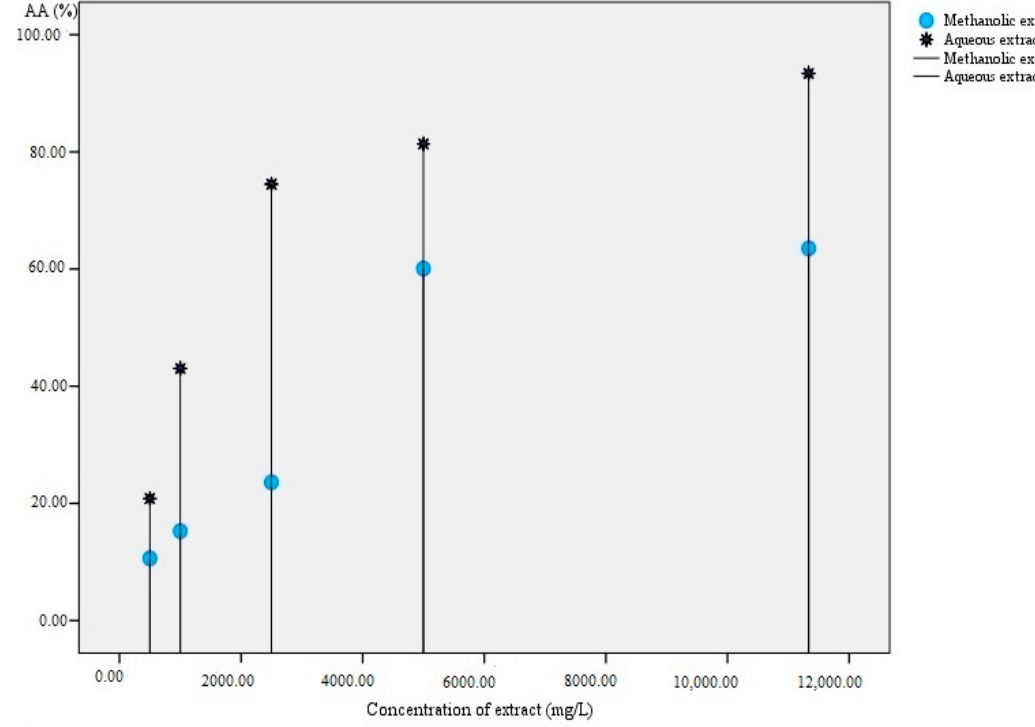
Figure 2. Antioxidant activity (AA%) of Lavavdula stoechas with respect to extract concentration (mg L − 1 ). antioxidant activity and the total phenolic content of the methanolic and aqueous extracts using